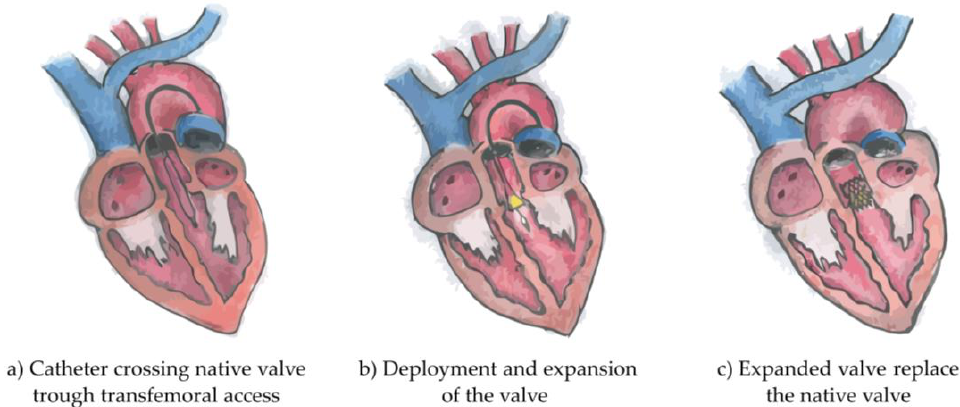
Figure 1. Illustration of the three phases of Transcatheter Aortic Valve Implantation intervention. Originally the catheter crosses the native valve trough transfemoral access ( a ), follows the deployment and expansion of the valve ( b ) and finally the expanded valve replaces the native valve ( c ).